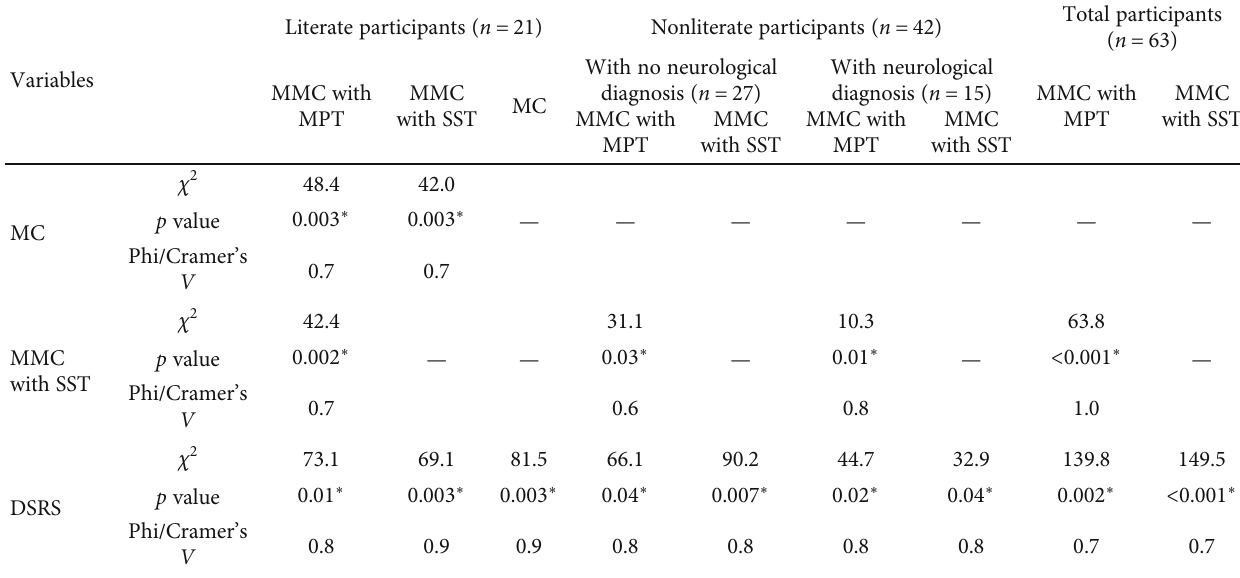
Table 2: Association between di ff erent Mini-Cog versions and with